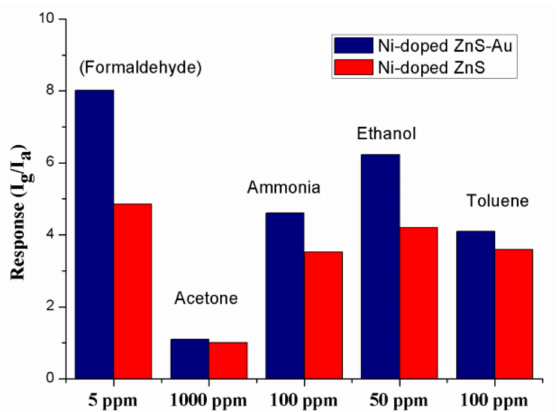
Figure 4. Sensitivities of the gas sensors based on pristine ZnS nanospheres and Au-decorated Ni-doped ZnS nanospheres to different gases at room